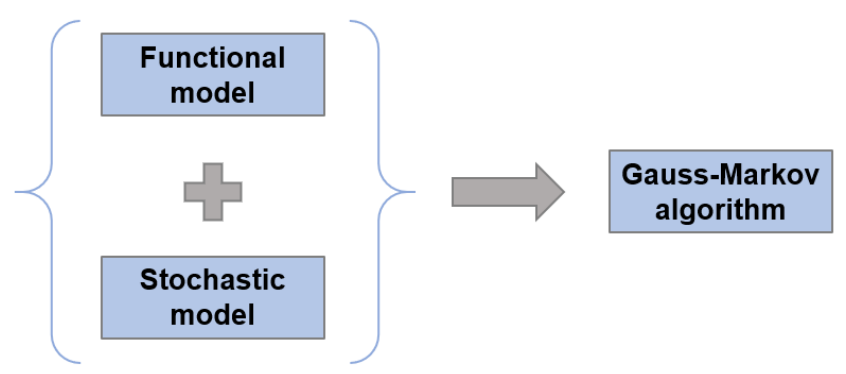
Figure 1. Methodology used for estimating long-term impacts of mining operations (residual subsi- dence and their duration) using the Gauss–Markov